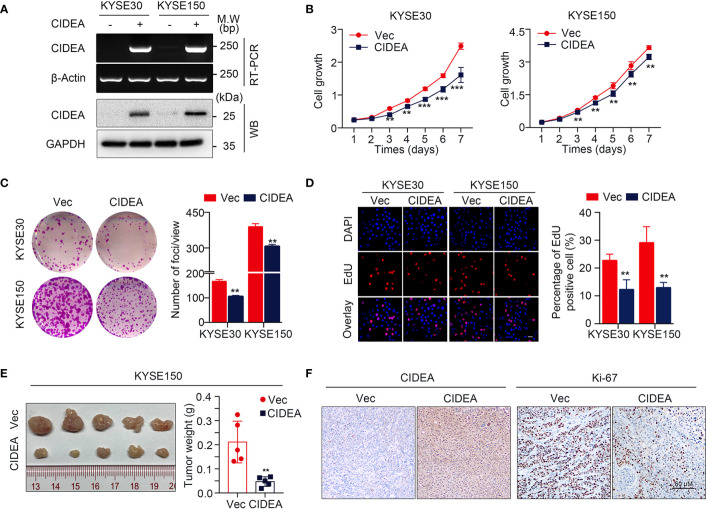
Ectopic expression of CIDEA suppressed ESCC tumor growth. (A) CIDEA mRNA and protein levels were detected by RT-PCR and Western blotting in CIDEA-transfected KYSE30 and KYSE150 cells. GAPDH or β-actin was used as the loading control. (B) Cell growth rate in CIDEA-transfected and empty vector-transfected KYSE30 and KYSE150 cells was measured by CCK8 proliferation assay for 7 consecutive days. (C) Representative images of decreased foci formation in monolayer culture induced by CIDEA overexpression in KYSE30 or KYSE150 cells. (D) Representative images (left) and quantitative statistics (right) of EdU incorporation assay showed the decreased replication of DNA in cells induced by CIDEA overexpression. Red, duplicated cells; blue, cell nucleus. Scale bars, 50 μm. (E) Images of xenograft tumors derived from KYSE150-transfected cells their vectors in nude mice. Tumor weights were compared between CIDEA over-expressing and control cells. (F) Representative IHC images of CIDEA and Ki-67 expression in xenograft tumors derived from CIDEA over-expressing and control cells. Scale bar = 50 μm. Statistical data are represented as mean ± SD. *P < 0.05; **P < 0.01; ***P < 0.001.